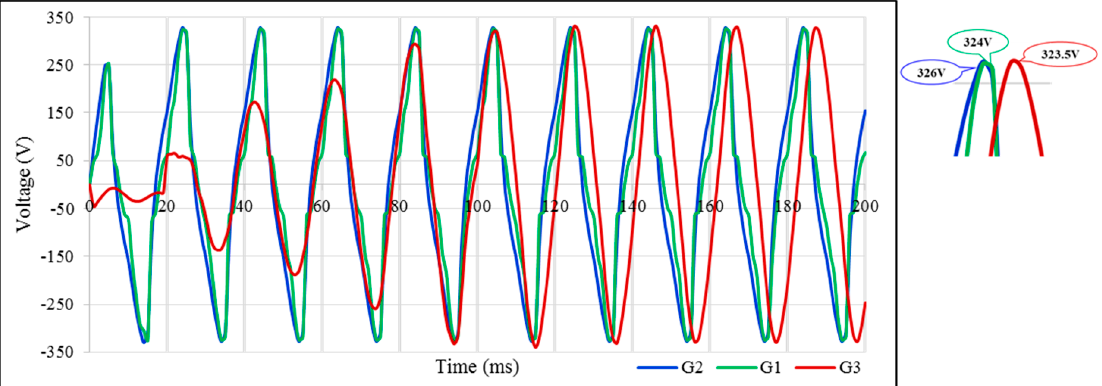
Figure 8. Full load voltage of G1, G2, and G3.